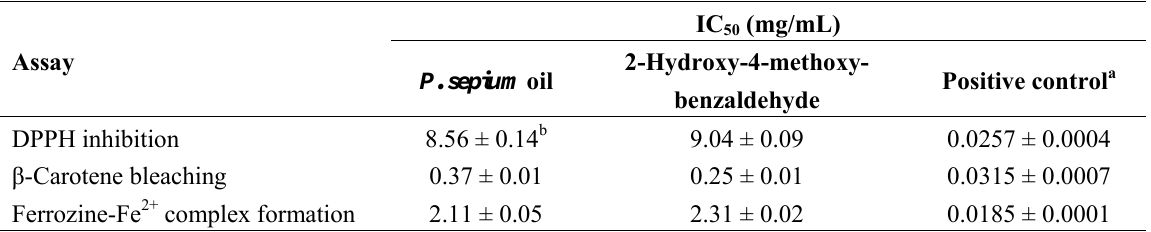
Table 3. Antioxidant activity of P. sepium essential oil and 2-hydroxy-4-methoxy benzadehyde. IC (mg/mL) 50 Assay 2-Hydroxy-4-methoxy- P. sepium oil Positive control a benzaldehyde DPPH inhibition 8.56 ± 0.14 b 9.04 ± 0.09 0.0257 ± 0.0004 0.37 ± 0.01 0.25 ± 0.01 0.0315 ± 0.0007 Ferrozine-Fe 2+ complex formation 2.11 ± 0.05 2.31 ± 0.02 0.0185 ±